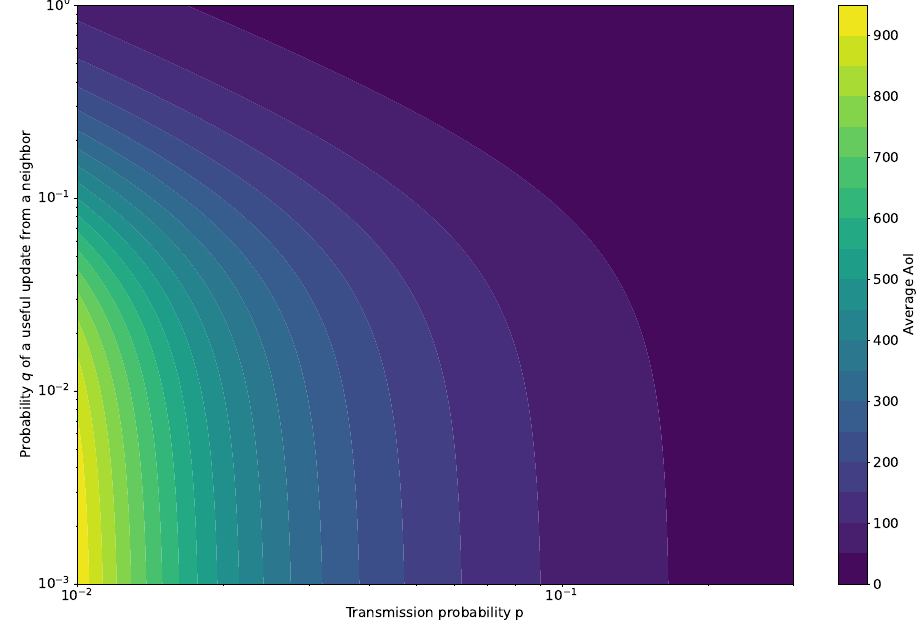
Figure 3. Average AoI obtained from the theoretical framework with N =